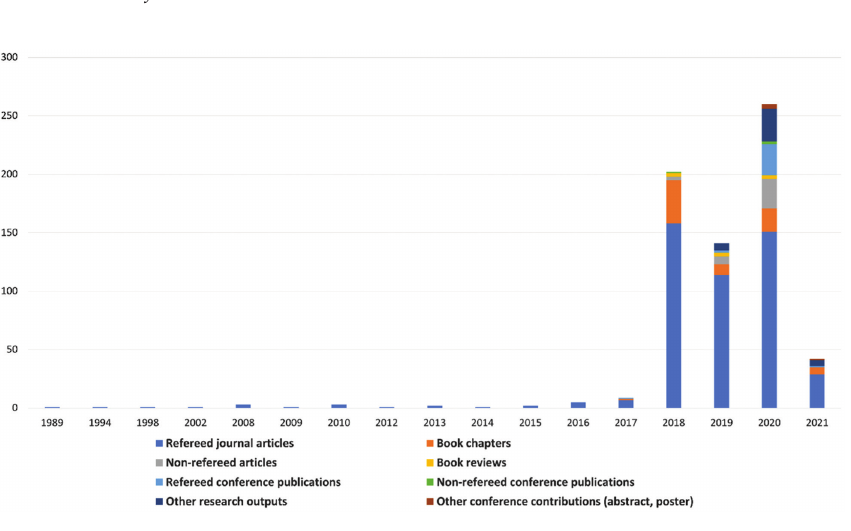
Fig. 1: Number of articles by publication year of short works at University Leiden released under Article